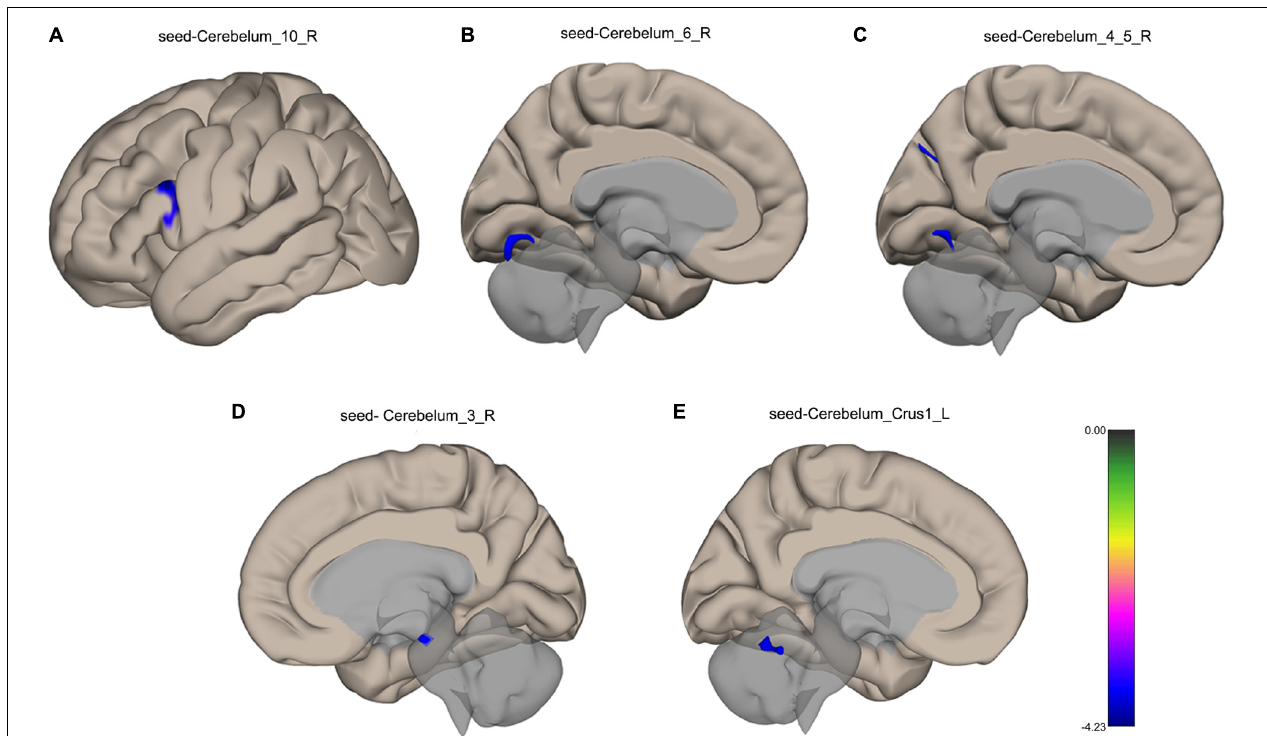
FIGURE 3 | Surface maps for the between-group comparisons of functional connectivity. (A) Decreased functional connectivity from the Cerebelum_10_R to the left Inferior Frontal Gyrus in TLE patients. (B) Decreased functional connectivity from the Cerebelum_6_R to the left Lingual Gyrus in TLE patients. (C) Decreased functional connectivity from the Cerebelum_4_5_R to the left Lingual Gyrus, left Cuneal Cortex and Precuneous Cortex in TLE patients. (D) Decreased functional connectivity from the Cerebelum_3_R to the Brain-Stem in TLE patients. (E) Decreased functional connectivity from the Cerebelum_Crus1_L to the Cerebellum 6 R in TLE patients. The blue color shows a decreased functional connectivity. FDR correction, p < 0.05.